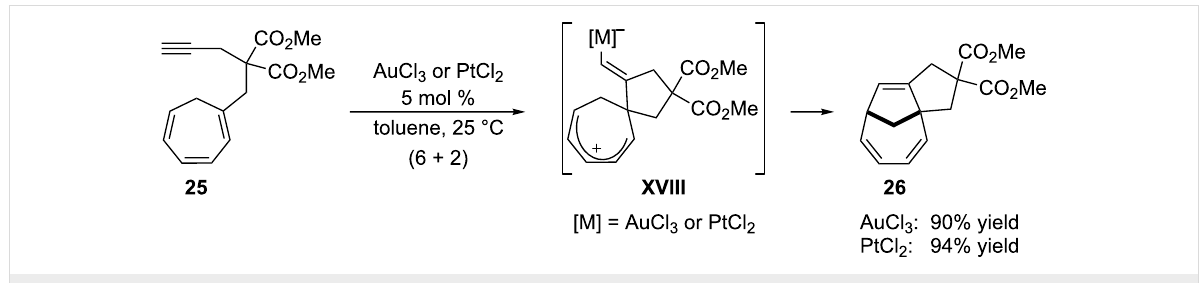
In addition to all of these cycloadditions involving the participa- tion of an alkyne and a second component, several gold- catalyzed formal cycloadditions of three different reaction components have also been described. In particular, the